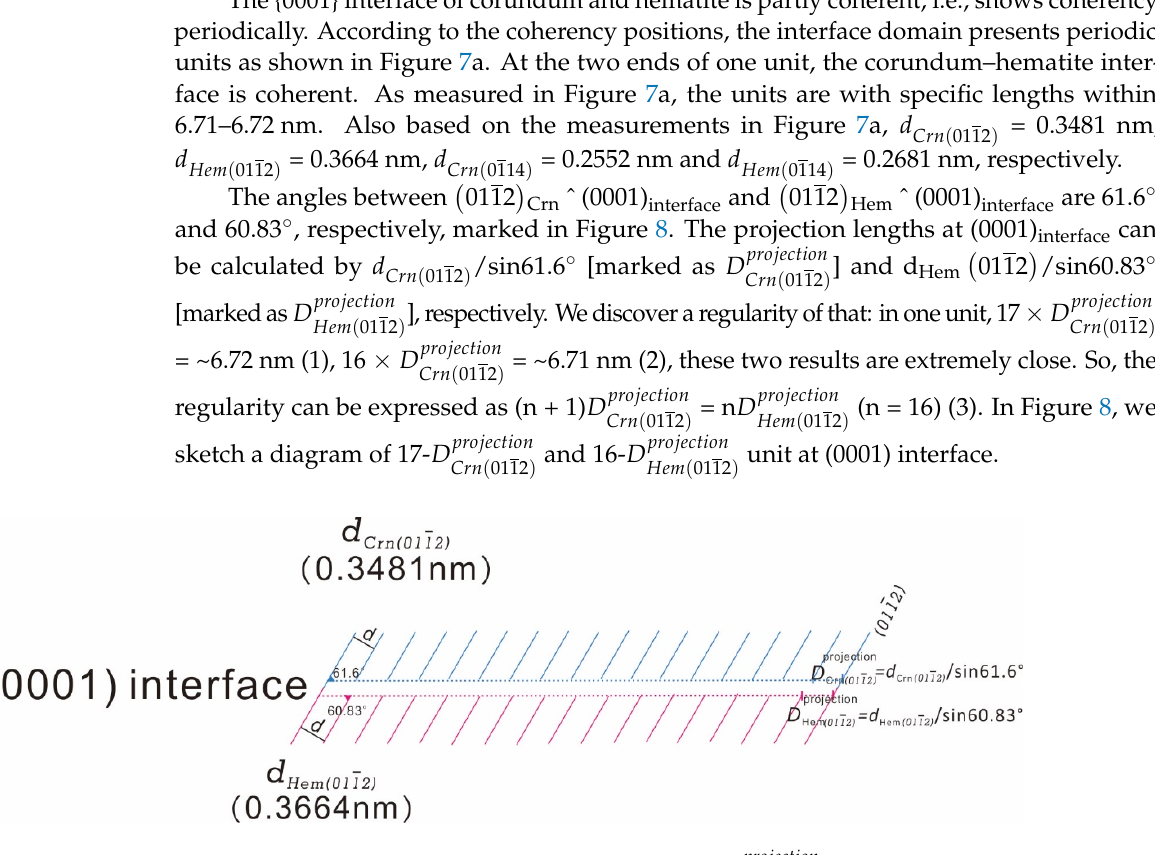
Figure 8. Sketch diagram of 17-  () /sin61.6° [17-  () [16-  ] forming a unit at the